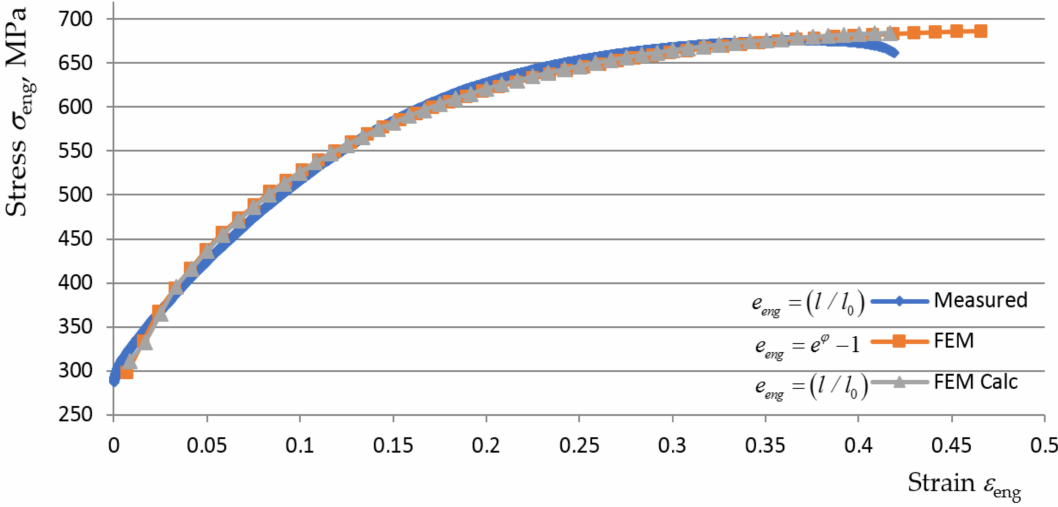
Figure 14. Stress–strain diagram obtained from tensile tests and FEM simulations.